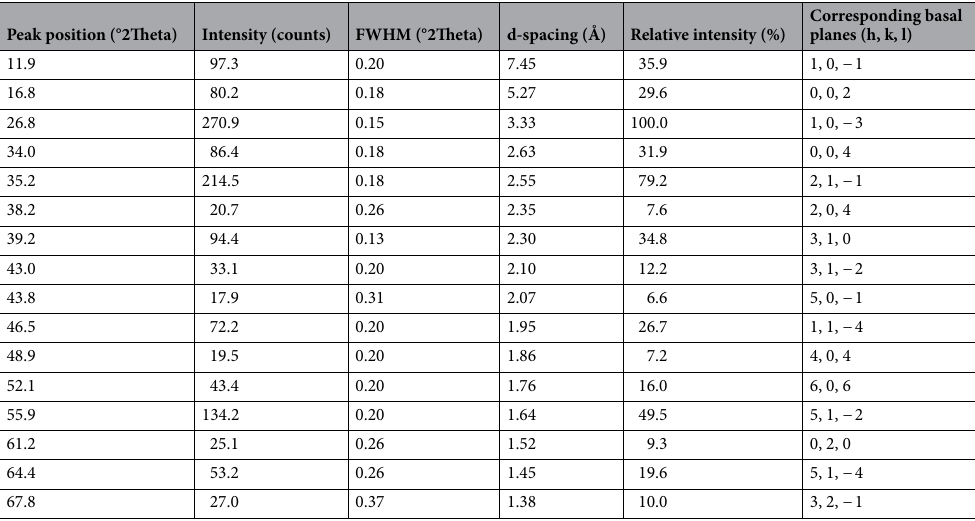
Table 1. List of peaks detected from the XRD analysis of synthetic